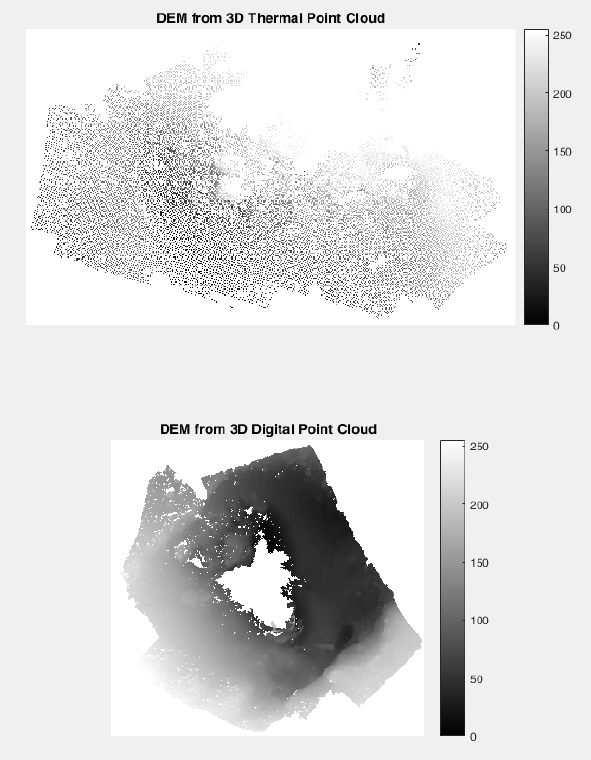
Figure 4. DEMs obtained from the thermal and digital point